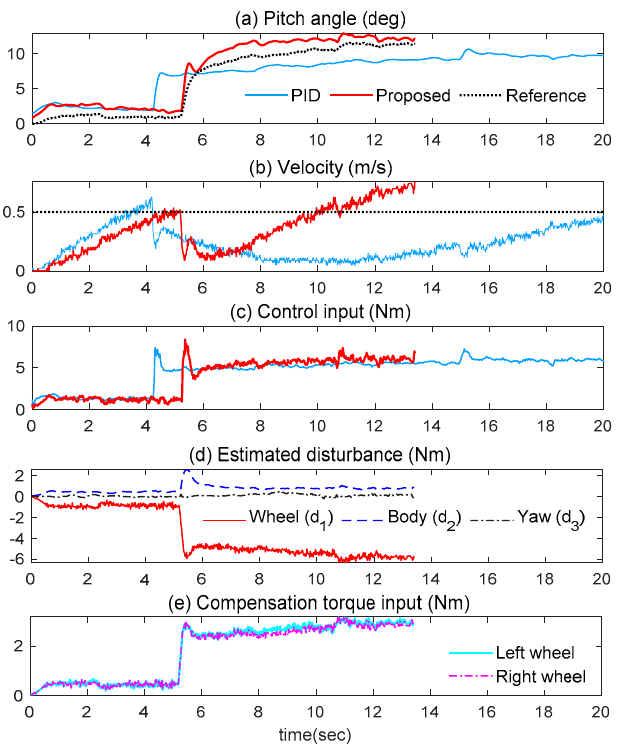
Figure 15. Effect of the terrain uncertainty during uphill driving.